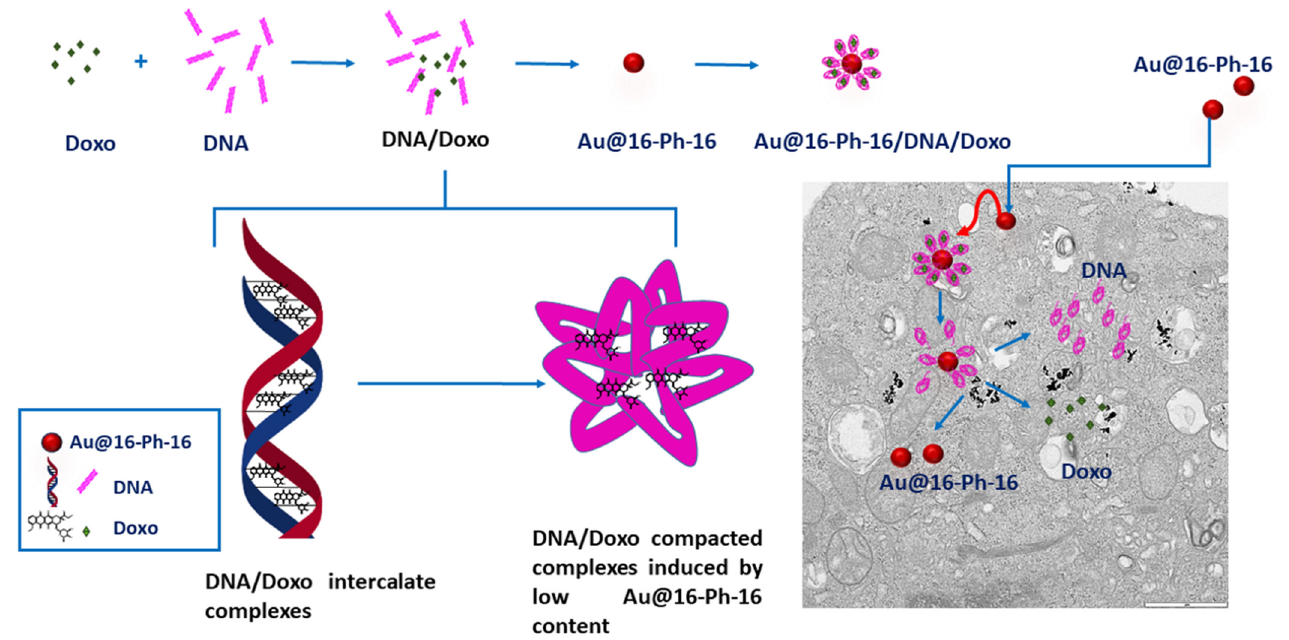
Figure 14. Scheme showing the synthesis of gold nanosystems with Doxo, DNA and gemini surfactants (Au@16-Ph-16/DNA–Doxo), and how the compaction/decompaction processes occur in DNA–Doxo complexes induced by Au@16-Ph-16. The formation of intercalated DNA/Doxo complexes occurs first, followed by the formation of tight DNA/Doxo complexes induced by low Au@16-Ph-16 content. Finally, the internalization of compacted nanocomplexes occurs within the cell and the intracellular release of Doxo by administration of Au@16-Ph-16.